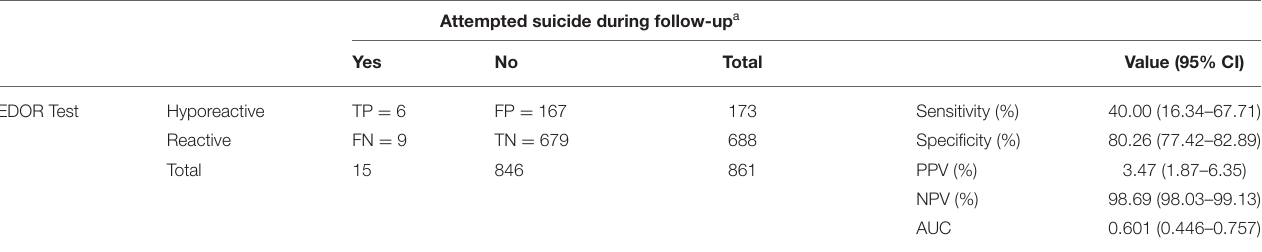
TABLE 5 | Sensitivity, specificity, and AUC of ElectroDermal Orienting Reactivity (EDOR) Test and suicide attempt during follow-up, excluding patients with a previous suicide attempt. Attempted suicide during follow-up